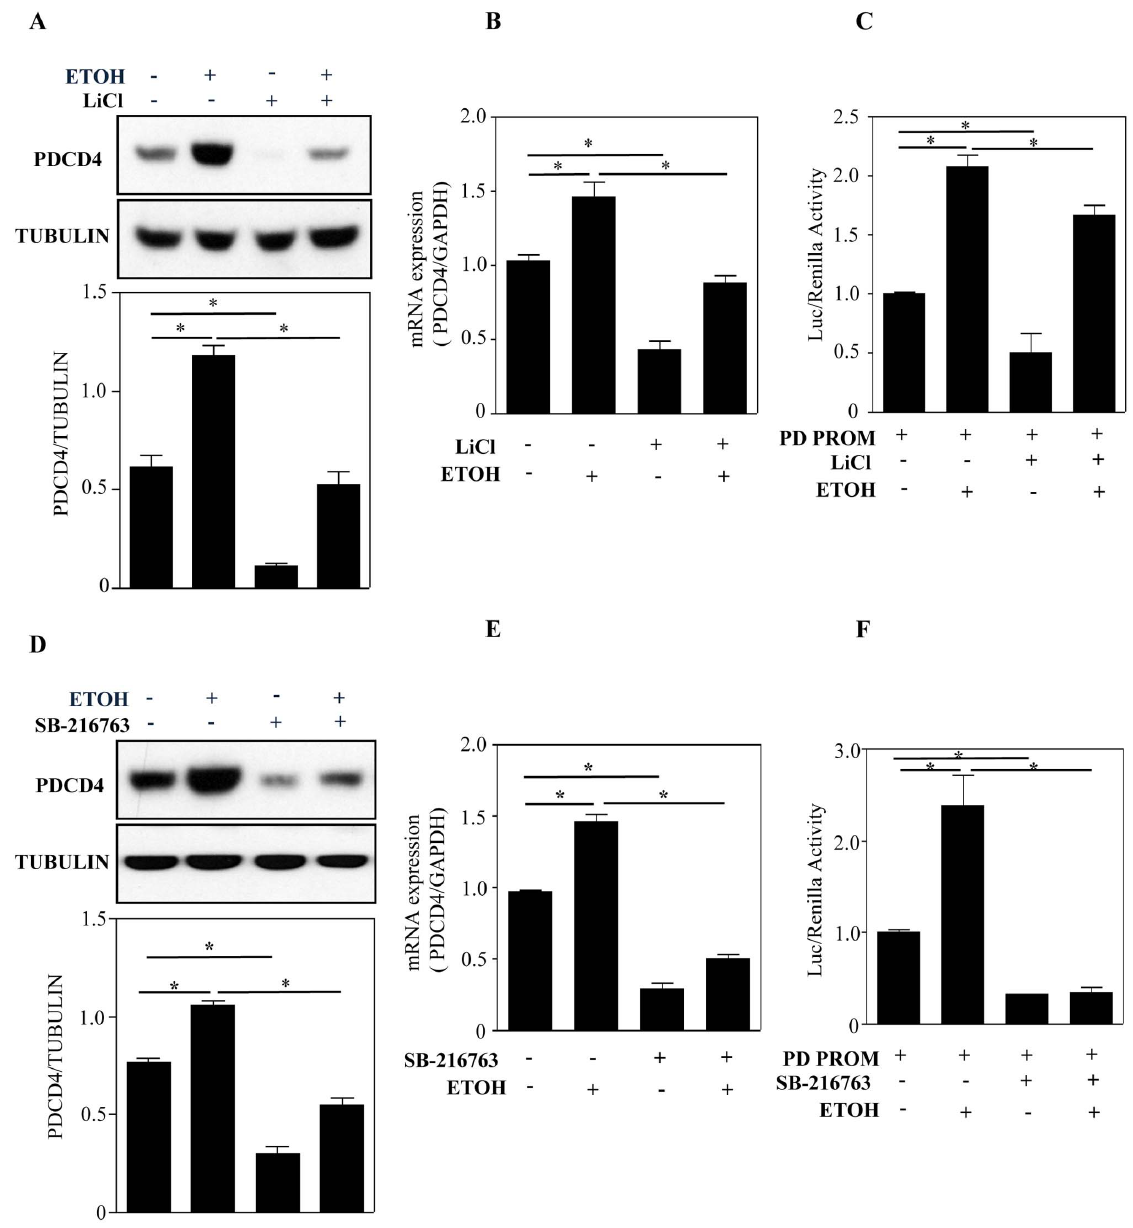
Figure 6. Chemical inhibition of GSK-3 b signaling pathway increases PDCD4 expression. Cells were pre-treated with with LiCl (10 mM) or SB-216763 (20 m M) for 1 h and then exposed with ETOH for 12 h. Panel A shows Western blot and densitometric scanning analysis of PDCD4 and tubulin with LiCl and ETOH treatment. ( B ) At the end of LiCl and ETOH treatment, cells were processed for qRT-PCR analysis to determine PDCD4 mRNA expression. Results are expressed as fold change in mRNA relative to GAPDH control. ( C ) Cells were transfected with either promoterless, pGL4.16 plasmid or 1046 bp PD PROM construct for 24 h. Following transfection, cells were pretreated with LiCl for 1 h and then exposed with ETOH for 12 h. After treatment, cells were processed for determining luciferase activity. Data are expressed as fold change relative to control. D , E and F depicts the Western blot analysis, RT-PCR analysis (expressed in fold change) and relative luciferase activity (expressed in fold change) when treated with SB-216763, a known GSK-3 b inhibitor. In A–F, statistical analysis was performed using one-way ANOVA followed by Newman-Keul’s posthoc correction. *is statistically significant at p , 0.05. n=6.